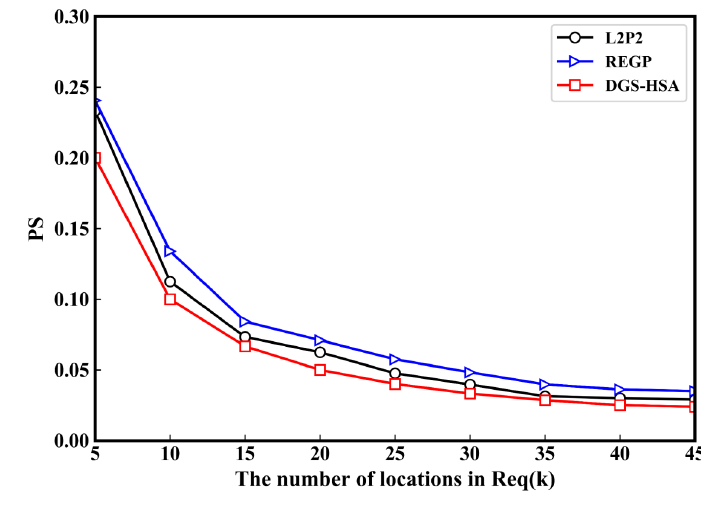
Figure 8. The probability P S that the user’s real query content is recognized varies with k .